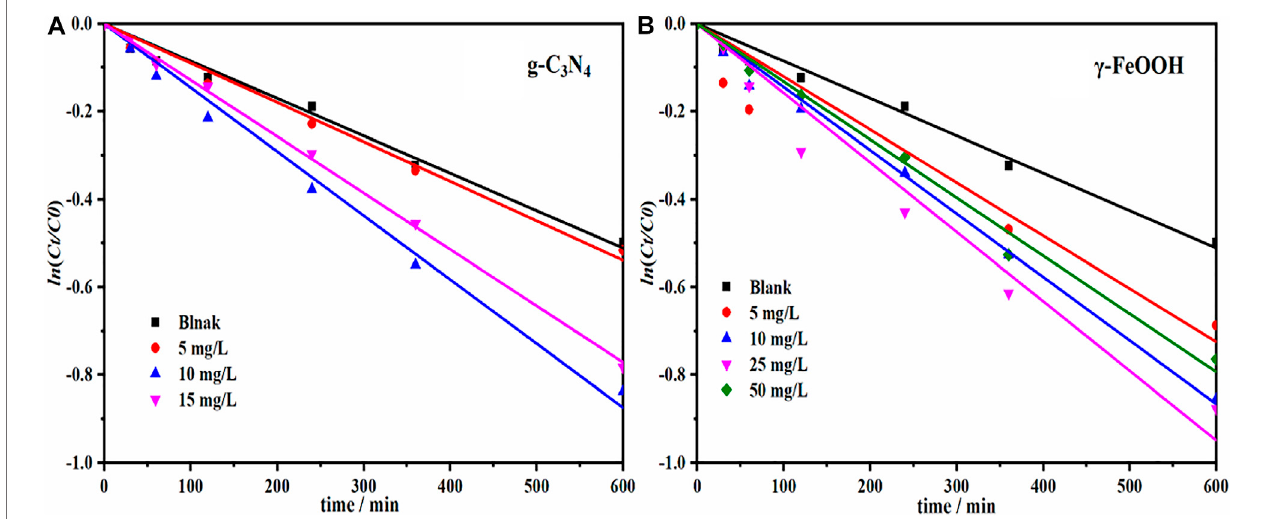
FIGURE 5 | (A) Catalytic degradation of SDZ by g-C 3 N 4 (The concentrations of g-C 3 N 4 were 0, 5, 10, 15, respectively) and (B) γ -FeOOH (The concentrations of γ -FeOOH were 0, 5, 10, 25, 30, respectively).